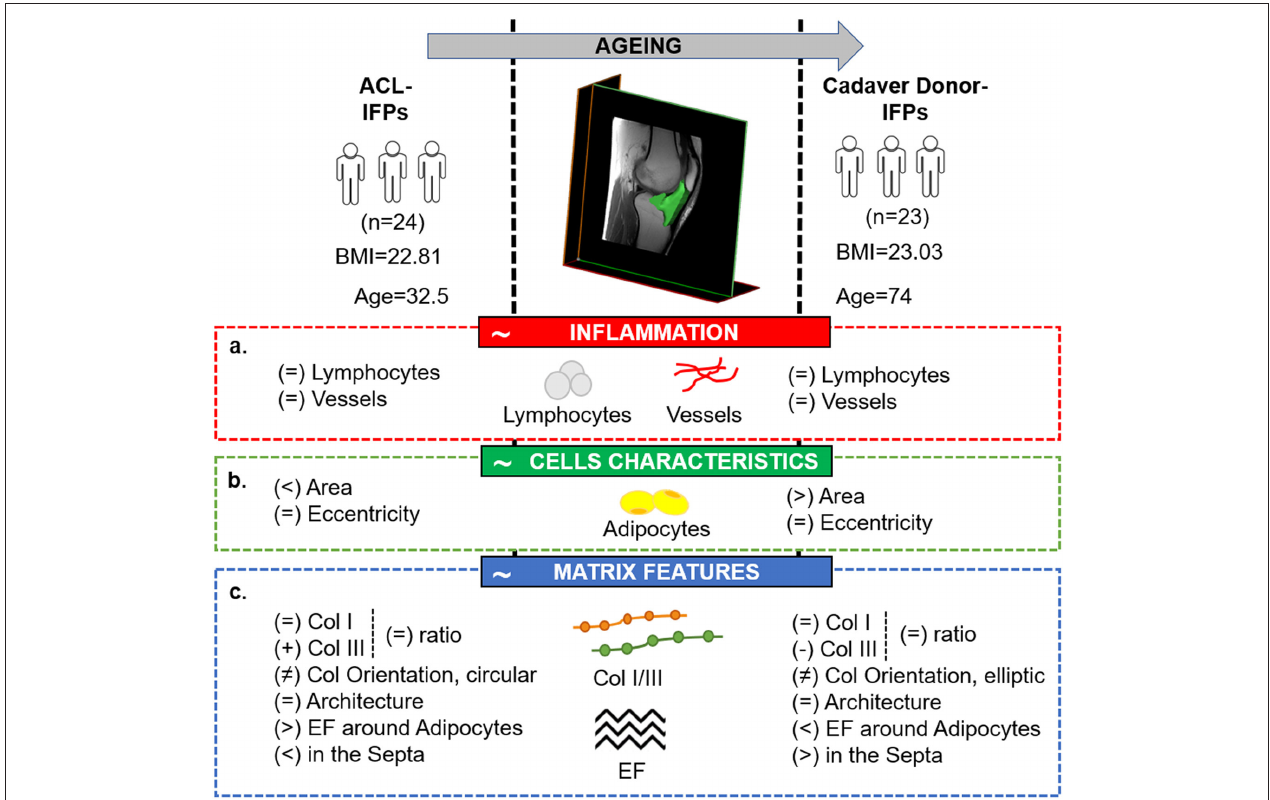
FIGURE 7 | Comparative picture between the two study groups, showing the tissutal specific features related to IFP physiological maturation, in case of the absence of carilage defect. The image highlights the main study findings with respect to the initial hypotheses which have been identified in the red (a. absence of inflammatory features in case of no cartilage lesions), green (b. variation in adipocytes area despite manteinence of the typical cells morphology with aging) and blue (c. reduction in extracellular matrix proteins and different distribution with aging) boxes, respectively. ACL, anterior cruciate ligament reconstruction; BMI; body mass index; Col, collagen; EF, elastic fibers; IFP, infrapatellar fat